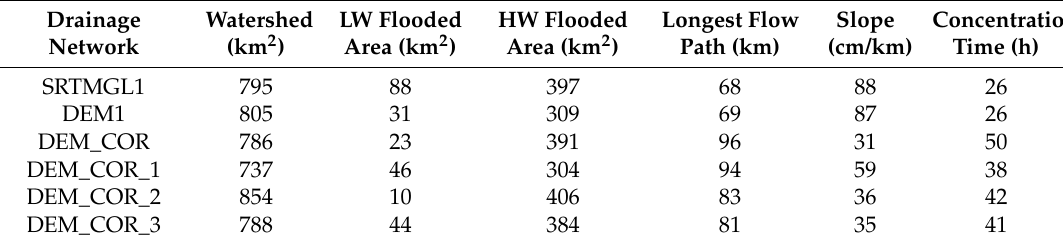
Table 5. Morphological characteristics of numerically delineated catchments from the different